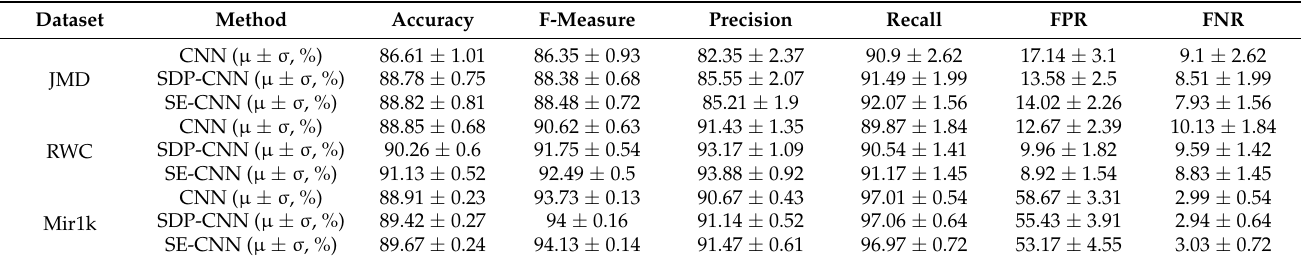
Table 3. The experimental results on the datasets: JMD, RWC, and